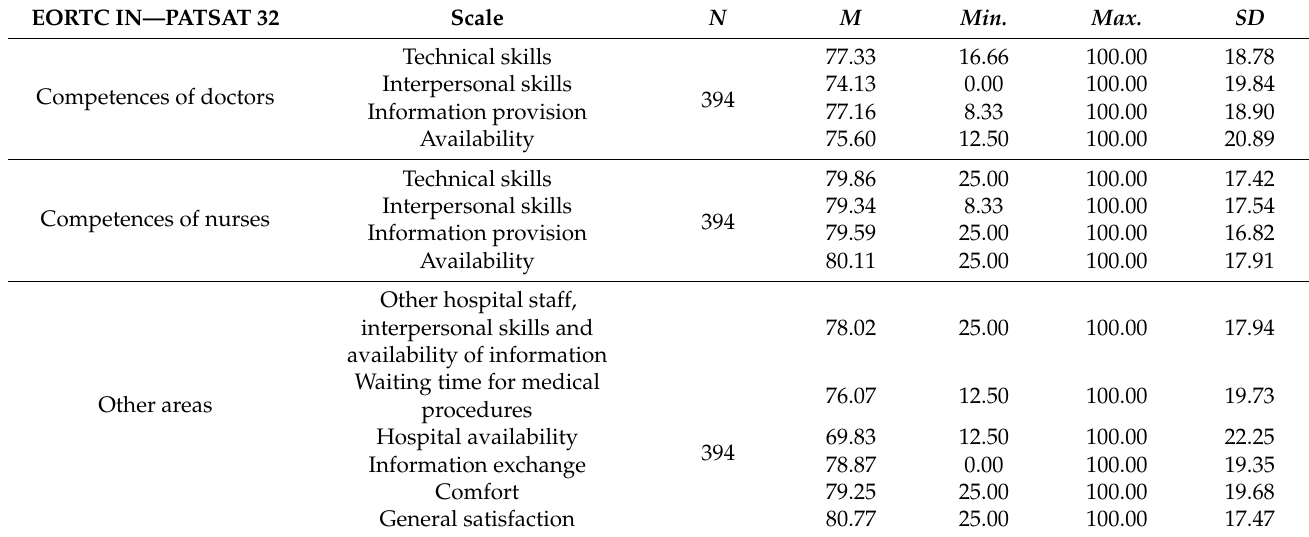
Table 4. Patient satisfaction with oncological care—results for EORTC IN—PATSAT 32. EORTC IN—PATSAT